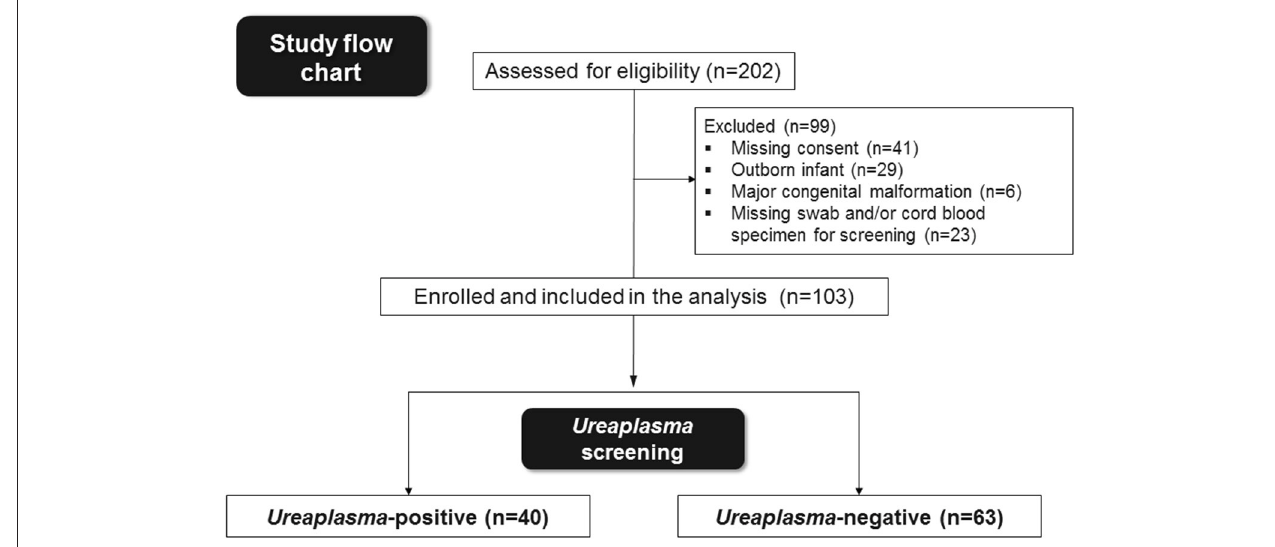
FIGURE 1 | Summary of preterm infants eligible, enrolled in the study and included in the final analysis.